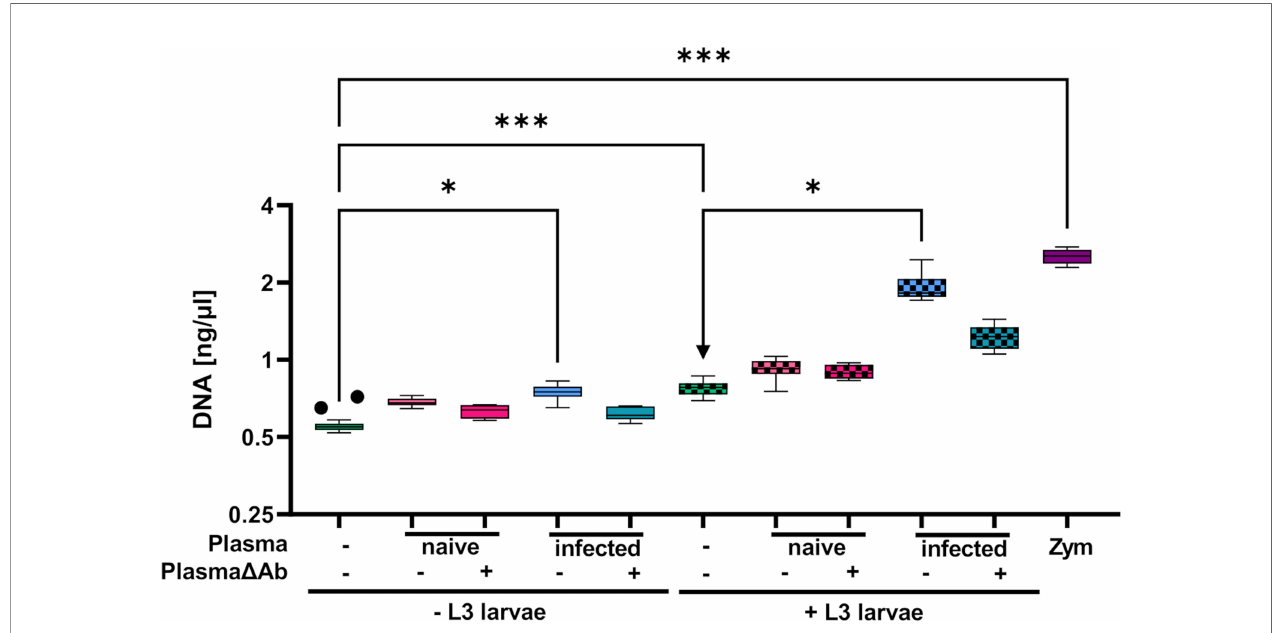
FIGURE 8 | Eosinophils release extracellular DNA (traps) in response to S. ratti L3 dependent on immune plasma. DNA quanti fi cation in the supernatant of eosinophils in culture with or without S. ratti L3 larvae supplemented with or left without plasma from S. ratti - infected or naïve animals. Plasma either contained antibodies or was depleted for antibodies (Plasma D Ab). Shown are box plots with tukey with n=5-20 (n=5: + Plasma D Ab and + L3 + Plasma D Ab, n=10: + Plasma and + L3 + Plasma, n=20: unstimulated and + L3 alone). One of two independent experiments. Kruskal-Wallis with Dunn ’ s post-hoc test. Only statistically signi fi cant comparisons are depicted, all other comparisons were statistically not signi fi cant. p < 0.05 *, p < 0.001